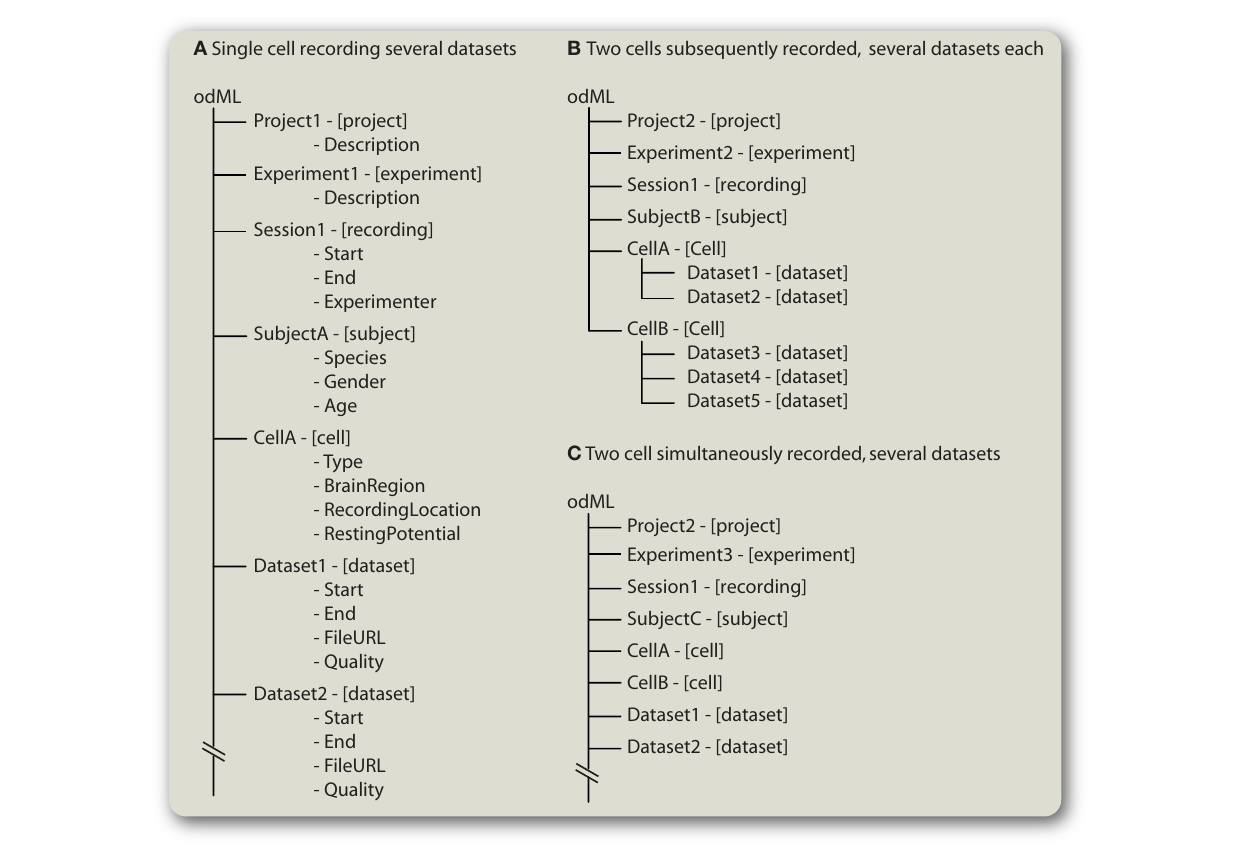
Figure 5 | Transporting dataset information in od ML. (A) Parts of the description of a simple electrophysiological experiment in which a single cell was recorded and several datasets were saved to disk. (B) Experiments in which